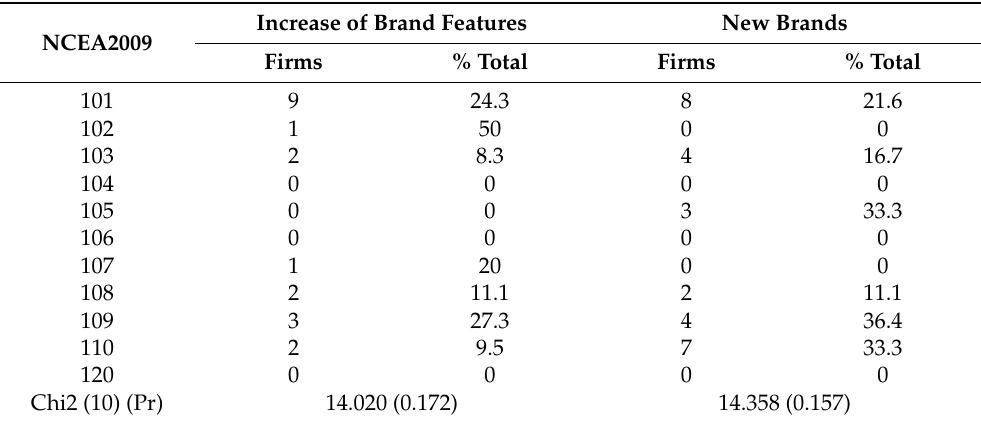
Table 9. Changes in the brand by the branch of